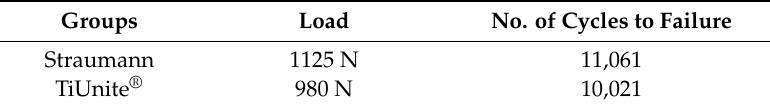
Table 2. Fatigue test results.